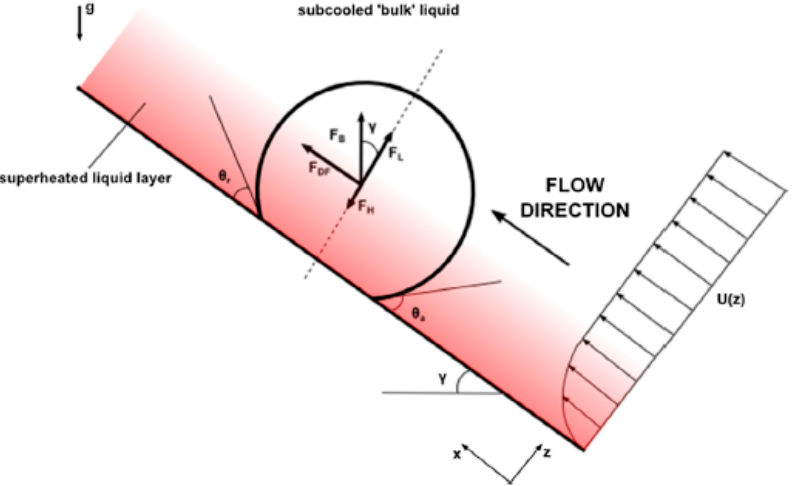
Figure 6. Hydrodynamic forces modelled by semi-mechanistic phenomenological bubble departure models, from Giustini et al. [30,32].